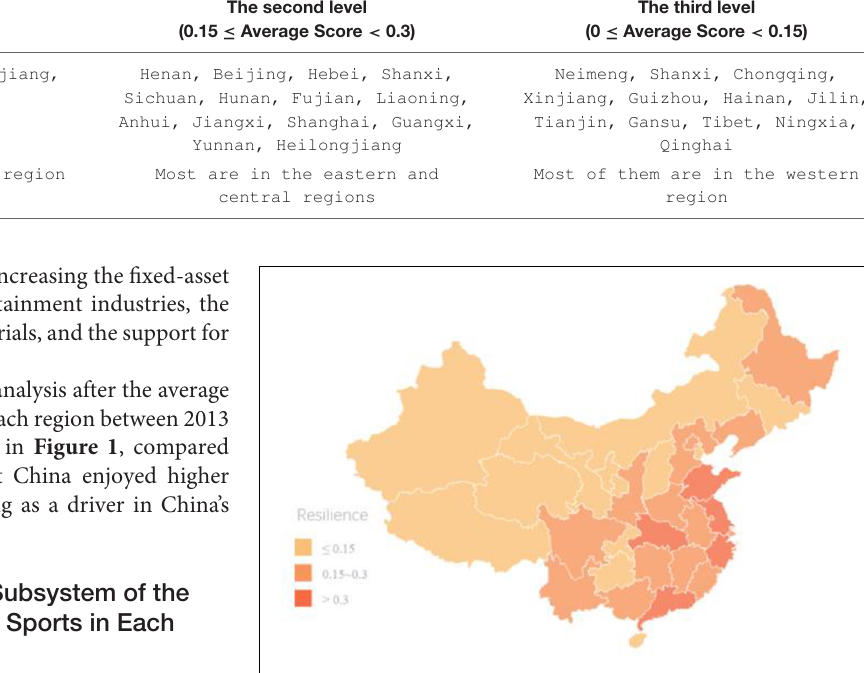
FIGURE 1 | Cluster distribution of average resilience level of sports regional development in